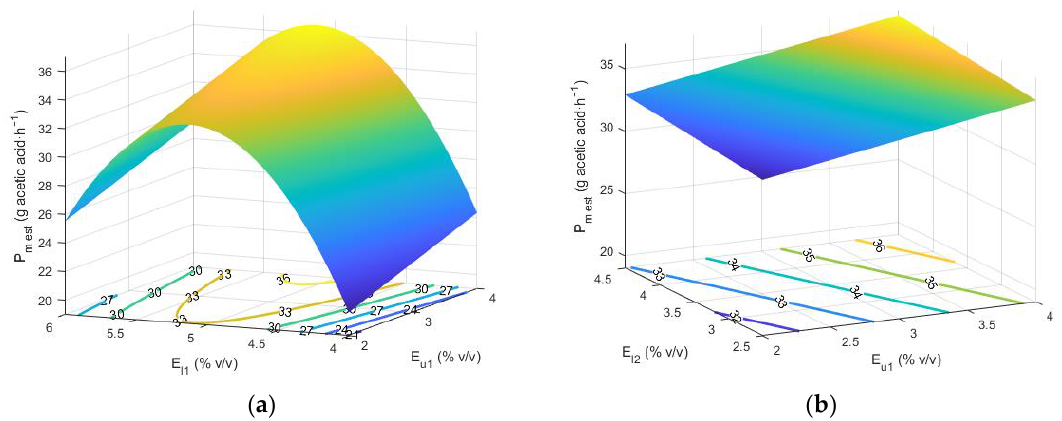
Figure 4. Response surfaces of P m est varying E l 1 and E u 1 ( a ) as well as E u 1 and E l 2 ( b ), using values from Table 8 for the remaining operational variables.